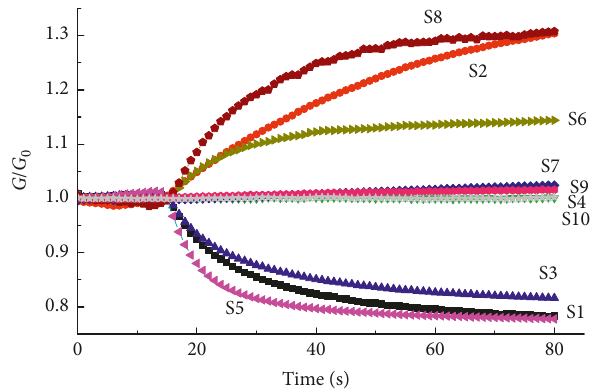
Figure 1: E-nose sensors’ response curve to minced mutton adulterated with 40% of pork (S1: ; S2: ; S3: ; S4: ; S5: ; S6: ; S7: